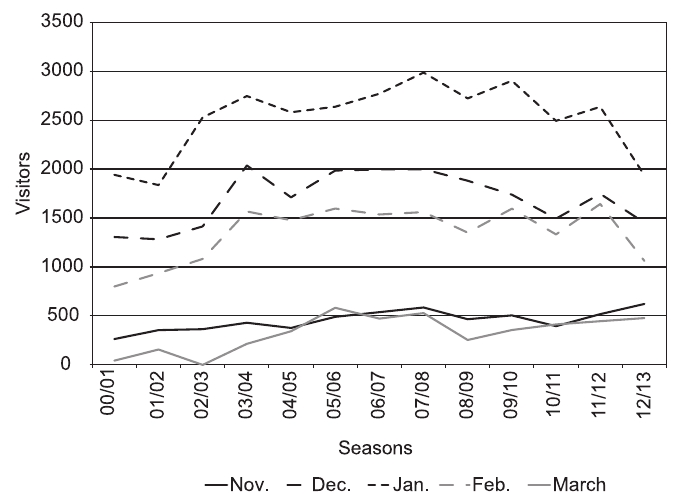
Fig. 7. Number of visitors in the Aconcagua massif in years 2000 to 2013 by